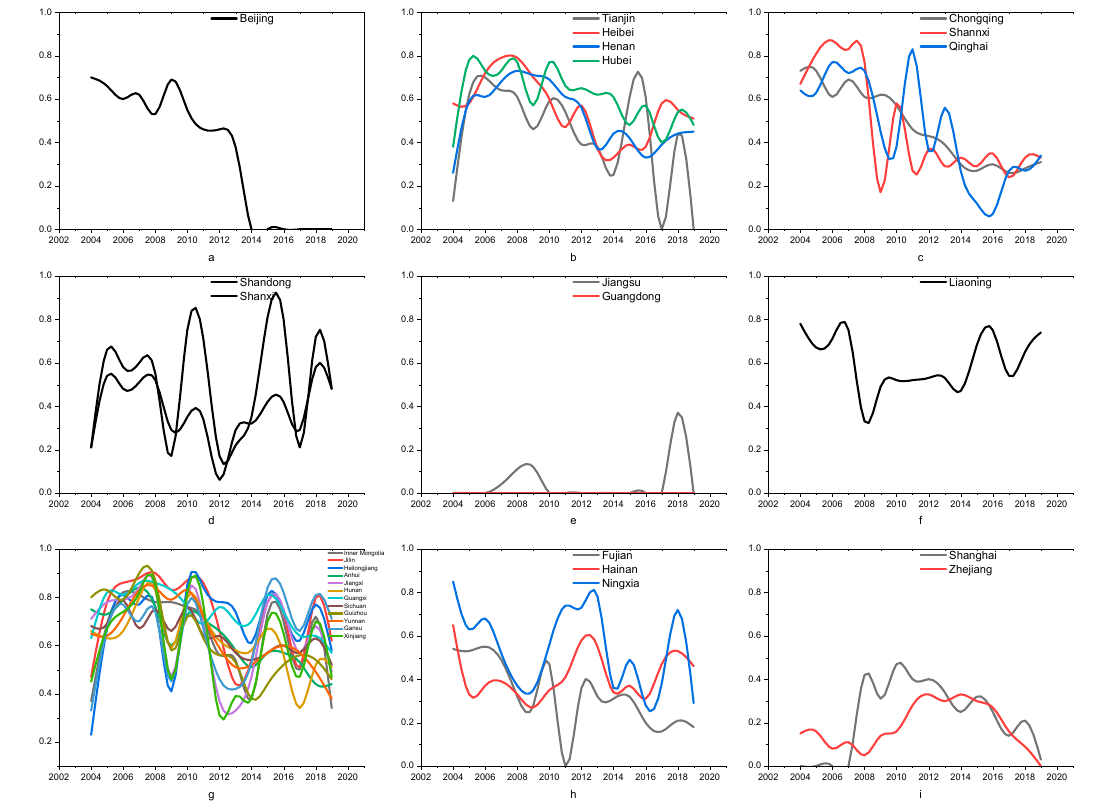
Figure 2. Mismatch ratio (Mi) of 30 provincial regions. ( a ) is the Mi of Beijing. ( b ) is the Mi of Tianjin, Hebei, Henan and Hubei. ( c ) is the Mi of Chongqing, Shaanxi, Qinghai. ( d ) is the Mi of Shandong and Shanxi. ( e ) is the Mi of Jiangsu and Guangdong. ( f ) is the Mi of Liaoning. ( g ) is the Mi of Inner Mongolia, Jilin, Heilongjiang, Anhui, Jiangxi, Hunan, Guangxi, Sichuan, Guizhou, Yunnan, Gansu, Xinjiang. ( h ) is the Mi of Fujian, Hainan, Ningxia. ( i ) is the Mi of Shanghai and Zhejiang.